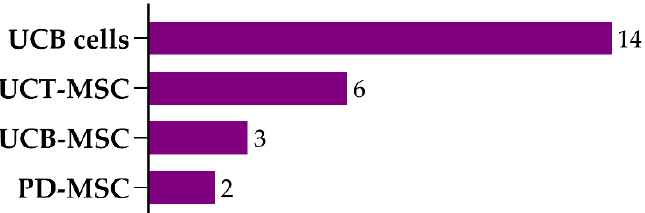
Figure 5. Number of protocols using different cell types isolated from neonatal tissues used in postnatal day-7 rats subjected to unilateral carotid artery occlusion, followed by 1.5–2.5 h of hypoxia. Abbreviations: UCB cells—umbilical cord blood cells; UCT-MSCs—umbilical cord tissue mesenchymal stem/stromal cells; UCB-MSCs—umbilical cord blood mesenchymal stem/stromal cells; PD-MSCs—placenta-derived mesenchymal stem/stromal cells.